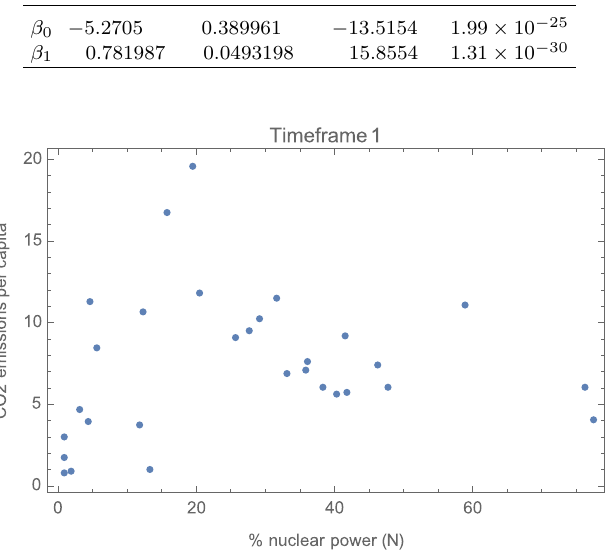
Fig. A.9. CO 2 as a function of N for the nuclear countries in time frame 1.